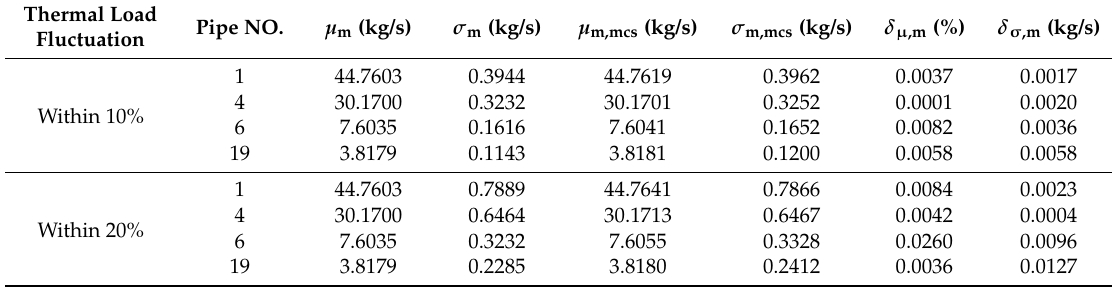
Table 5. Typical mean and standard deviations of mass flow rates. (Test 2: L = 1500 m; µ ϕ = 0.5